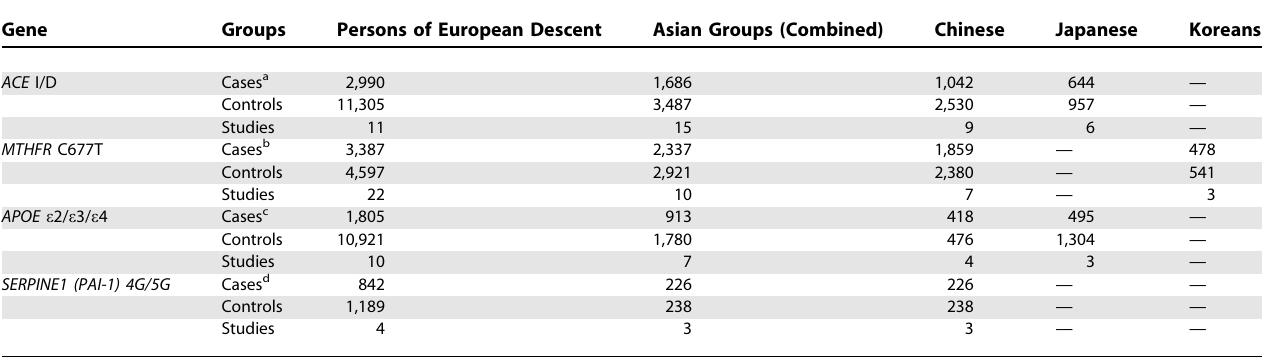
Table 2. Comparative Total Number of Cases, Controls, and Studies by Ethnicity Gene